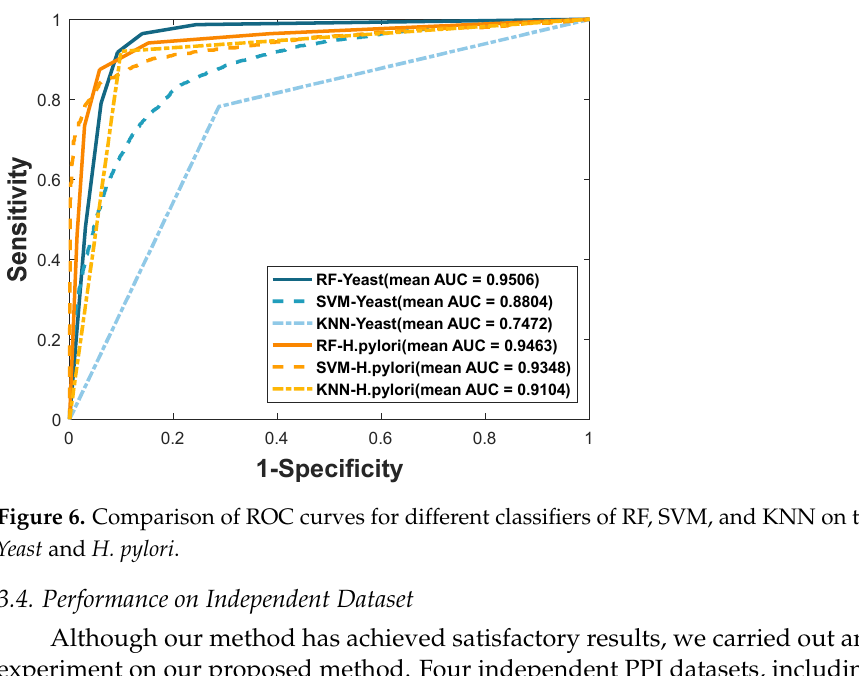
10 of 14 Table 6. The experimental results compared with other prediction models in the Yeast and H. pylori datasets. Dataset